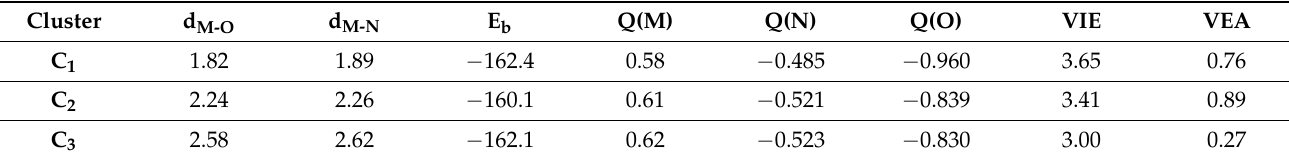
Clusters Figure 2. Binding energies per atom (E b ) of clusters. 2.2. Electronic Properties and Stability The electronic stability and superalkali nature of these clusters can be observed from calculated ionization potential and electron affinity. The obtained vertical ionization po- tential values are smaller than Cs-atom (3.89 eV), which shows the superalkali character- istics of these clusters. These values are also significant and account for the electronic sta- bilities of these clusters. The highest VIE value of 3.65 eV is found for C1, while the lowest value (3.0 eV) is indicated for the C3 cluster (Table 1). A gradual decrease in VIE values with the increased size of alkali metals can be seen in these clusters. On the other hand, the vertical electron affinity (VEA) values range from 0.27 to 0.89 eV, where C3 shows the lowest value. The reduced values of EA indicate the electropositive nature of these clus- ters.